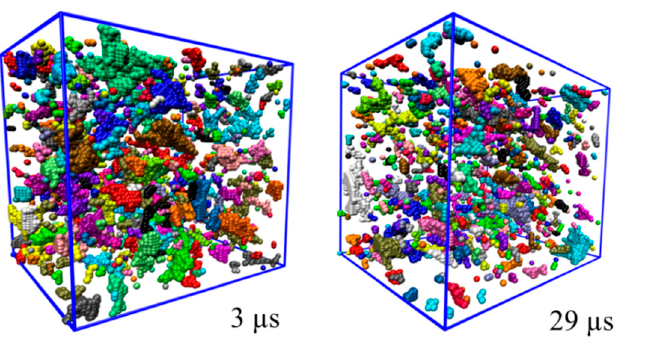
Figure 5. Snapshots of typical instant configurations of free volume distribution in the simulation box after 3 ( left ) and 29 ( right ) μ s respectively. Each pore has its own color.